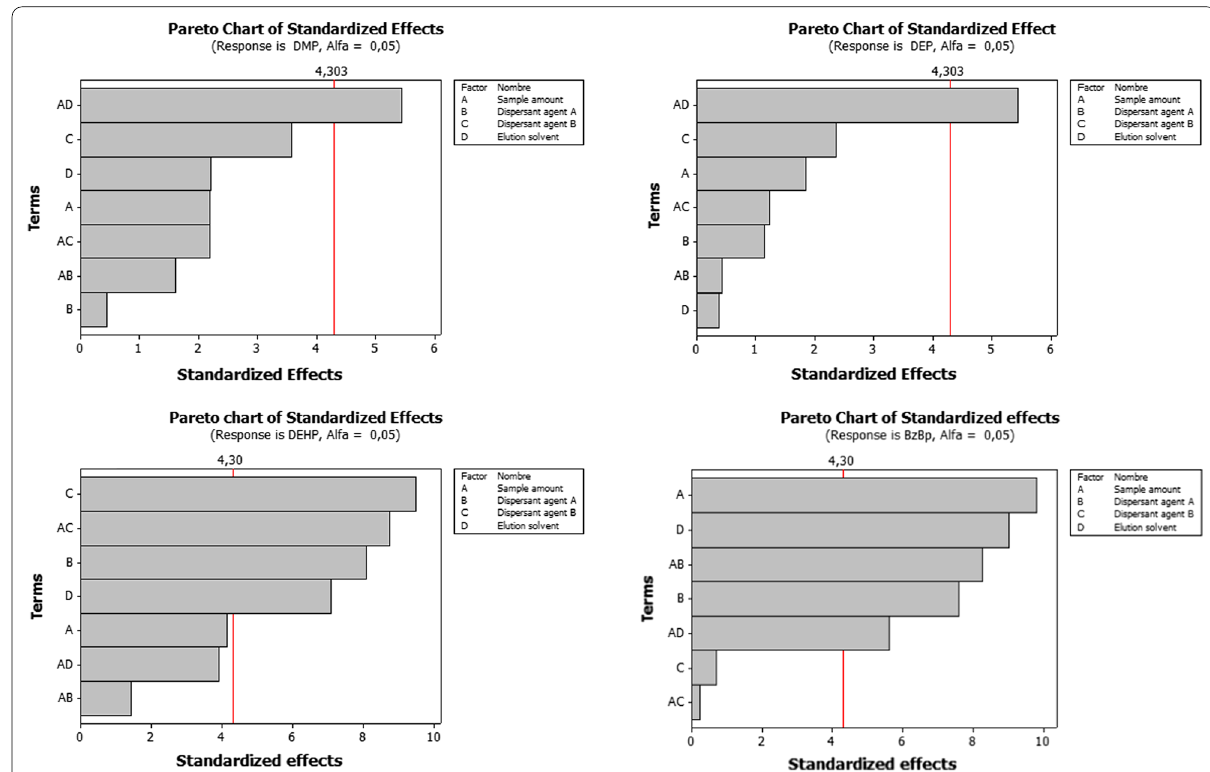
Fig. 1 Pareto chart of main effects for the experimental design, obtained by using the DMP (dimethyl phthalate), DEP (diethyl phthalate), DEHP (diethyl hexyl phthalate) and BzBP (benzyl butyl phthalate) recoveries. The vertical lines indicate the statistical significance bound for the